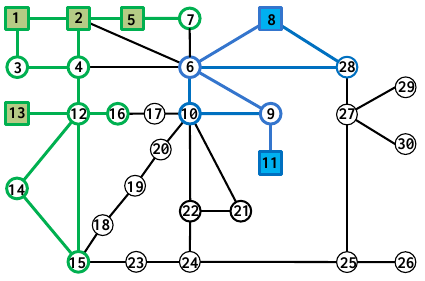
Figure 6. The 30-node graph in which G